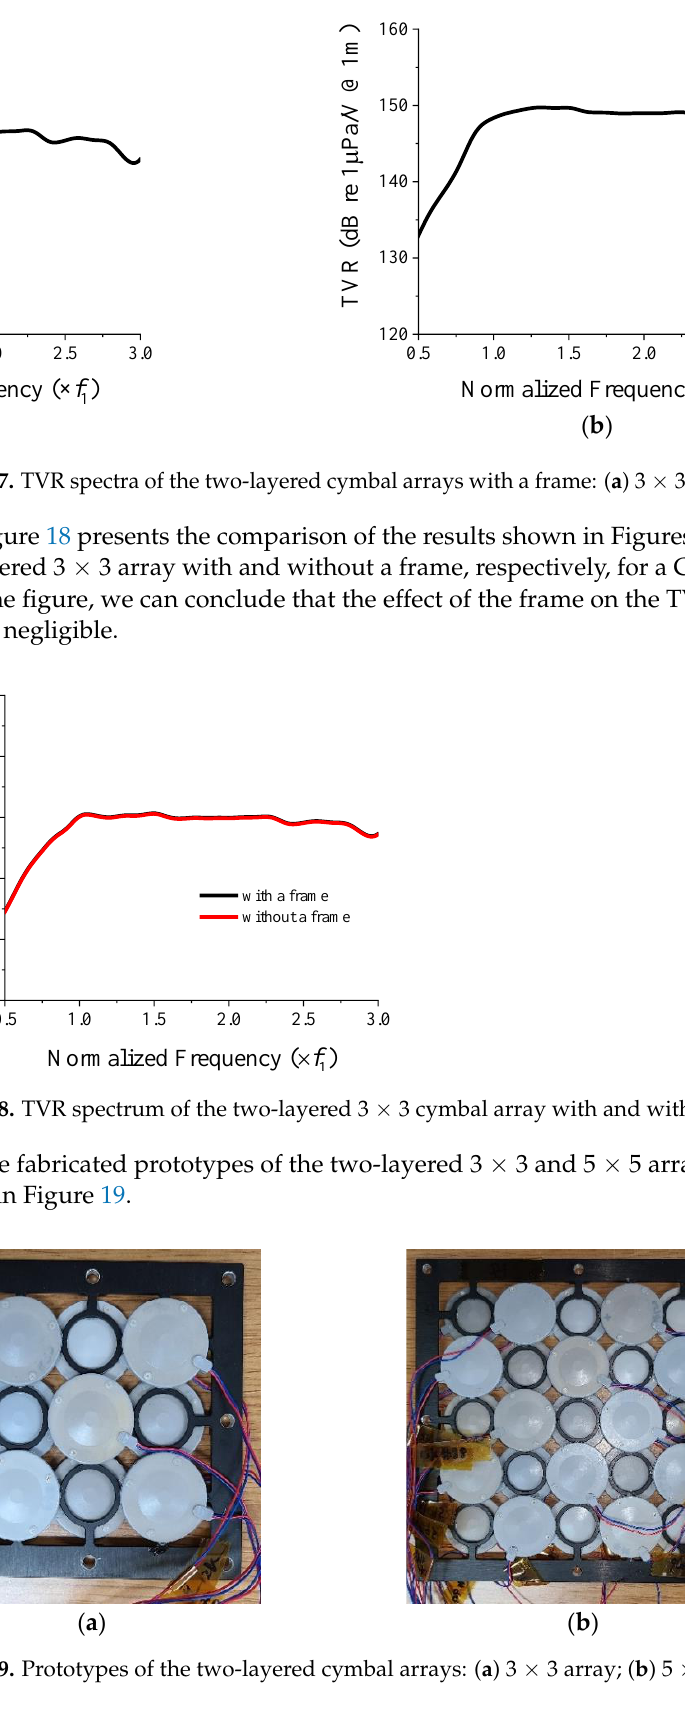
Figure 20. Schematic diagram of the experimental setup for TVR measurement. Table 5. Quantitative comparison of acoustic characteristics of the two-layered 3  3 and 5  5 cym- bal arrays based on FEA and measurement. Center Frequency (× f 1 ) Maximum TVR (dB)